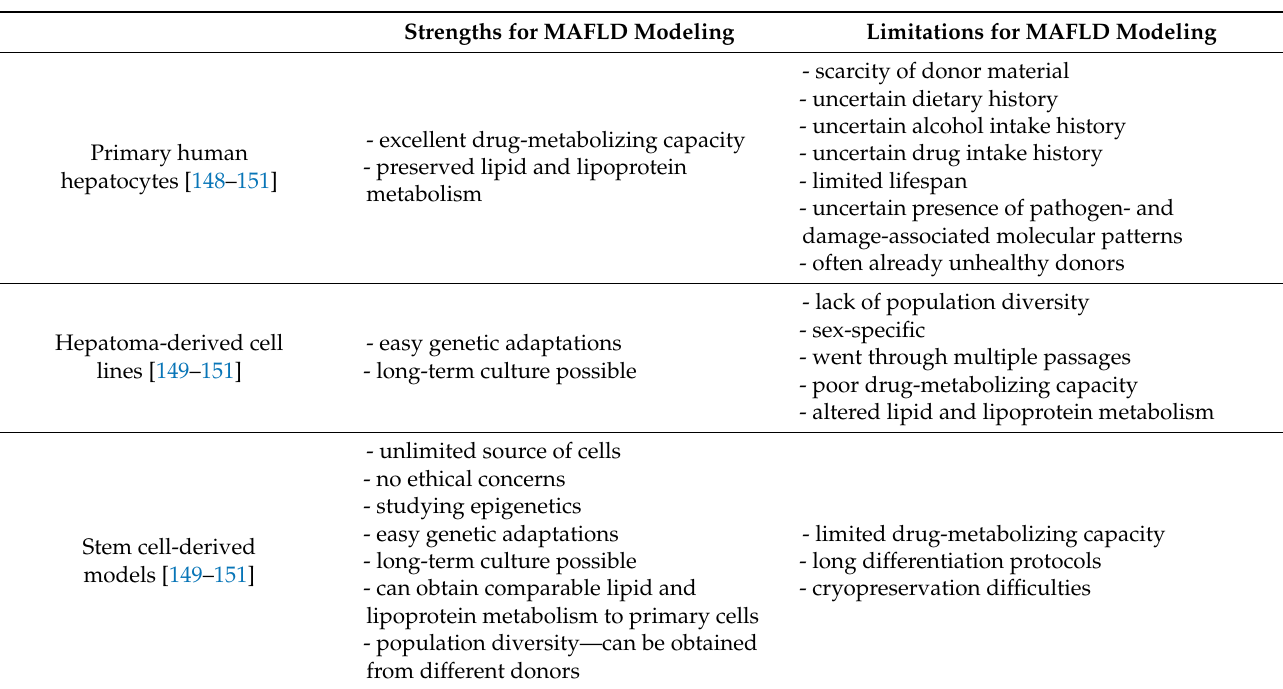
Table 3. Strengths and limitations of hepatic cell sources for modeling